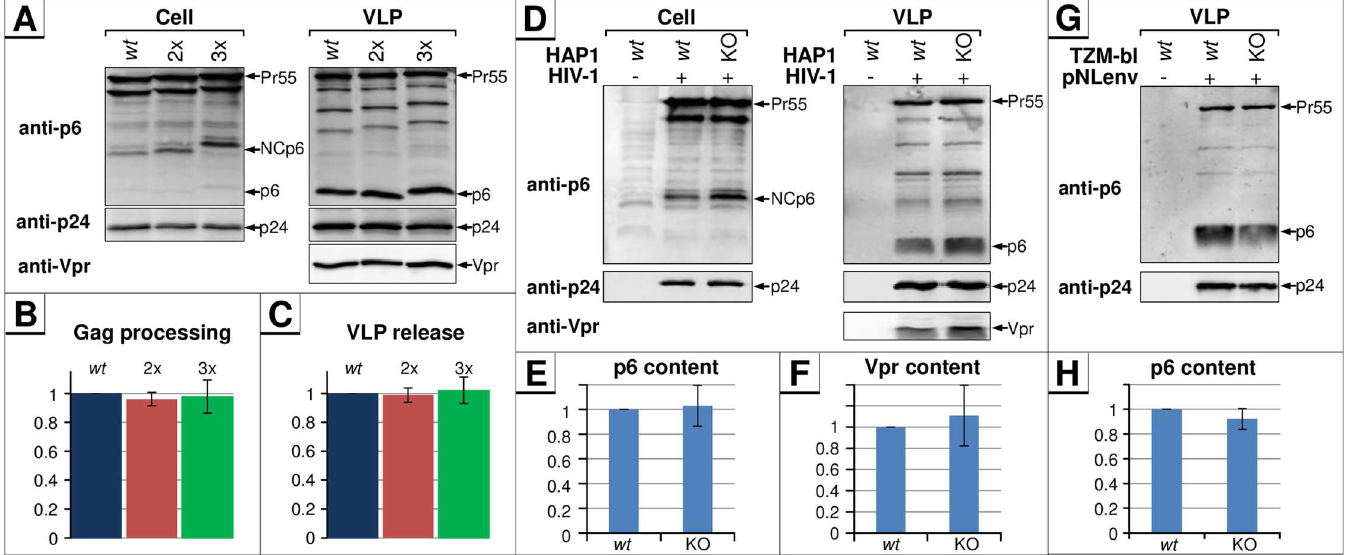
Fig 10. The IDE-p6-interaction has no effect on Gag-processing and virus release.(A) HEK293T cells were transfected with p Δ R plasmidsencoding for either wt Gag, or the p6 mutants 2xPTAPPA or 3xPTAPPA. Cells were lysed and VLPs were purifiedand subsequently analyzedby Western blot. Noteworthy, Gag processingand virus release of 2x and 3x PTAPPA mutants were comparable to that of the wt , only the apparentmolecularweight of p6 and the NCp6 processingintermediate increasedby PTAPPA multiplication. (B) The rate of Gag processingwas estimated by calculatingthe ratio of p24 vs. Pr55 detected in releasedVLPs. Bars represent mean values of three independentexperiments ± SD. (C) Efficiency of virus release was calculatedas the ratio of Gag (Pr55 and p24) present in the virus pellet relativeto the total amount of Gag detected in cells and released VLPs. Bars representmean values of three independentexperiments ± SD. Both Gag processingand virus release for the wt were set to 1. (D) HAP1 wt cells and HAP1 IDE knock out cells were infected with VSV-G-pseudotyped wt HIV-1 particles. 2 days post-infection, cell and virus-fractions were harvestedand analyzedby Western blot for viral proteins. Band intensities of virus-associated p6 (E) and Vpr (F) were quantifiedand normalized for p24 signals. Bars represent mean values of three independent experiments ± SD. (G) HeLa TZM-bl wt and IDE KO cells were transiently transfected with pNLenv1and virus and cell fractions were analyzed by Western blot. (H) Band intensities of virus-associated p6 were quantifiedas describedin (E).